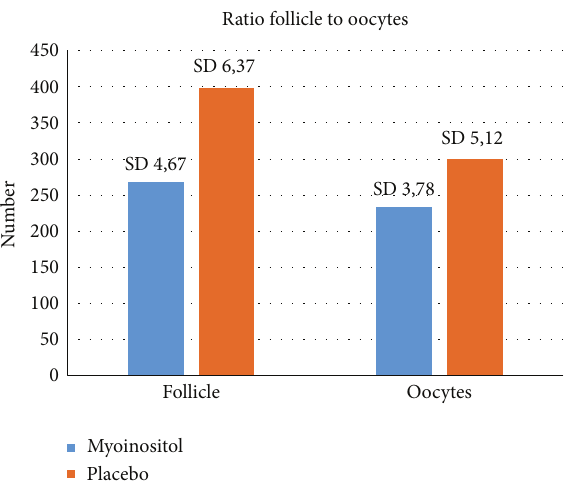
Figure 1: Ratio of follicles and retrieved oocytes. Statistically differences ( 𝑝 < 0.05 ) were observed. The amount of developed follicles was lower in the myoinositol group and in relation to this a higher number of oocytes were